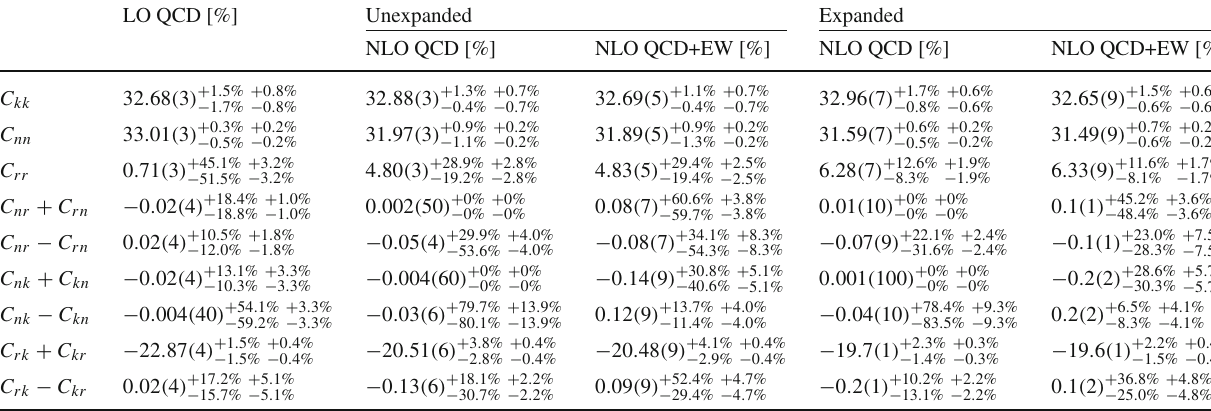
Table 2 The C coefficients as defined in Eq. (16) at various orders both expanded and unexpanded LO QCD [%] Unexpanded